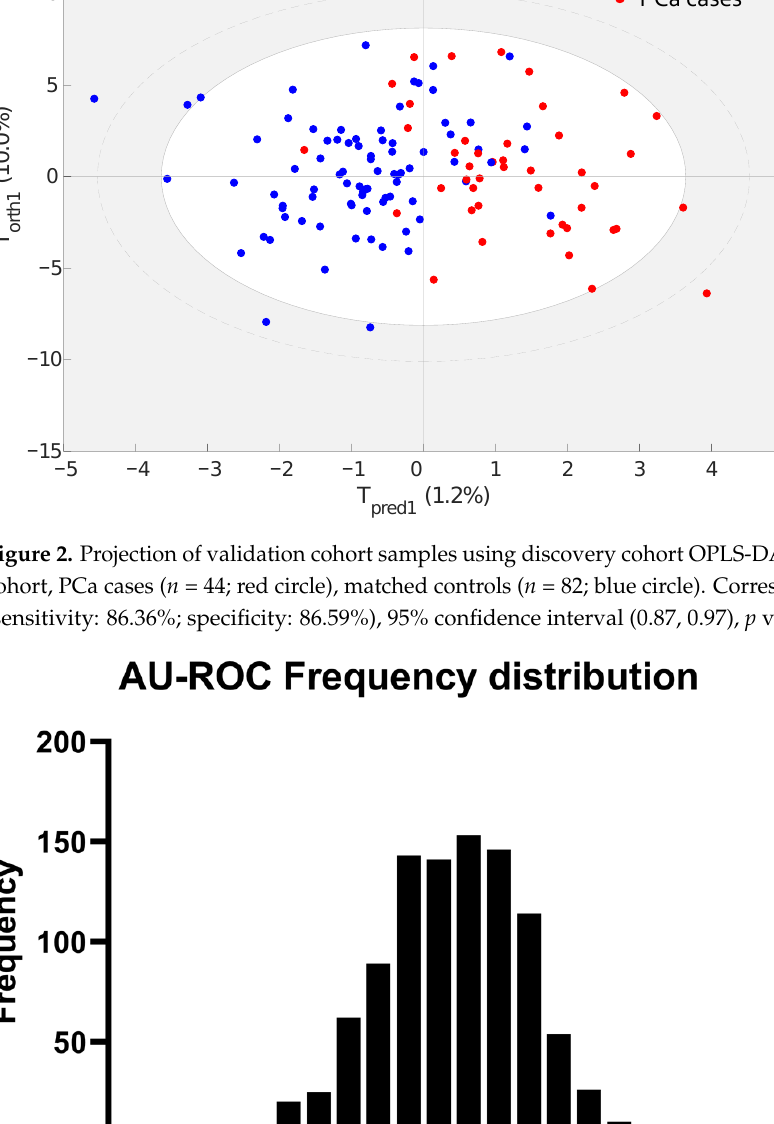
Figure 2. Projection of validation cohort samples using discovery cohort OPLS-DA model. Valida- tion cohort, PCa cases (n = 44; red circle), matched controls (n = 82; blue circle). Corresponding AUC: 0.92 (sensitivity: 86.36%; specificity: 86.59%), 95% confidence interval (0.87, 0.97), p value: < 0.0001.